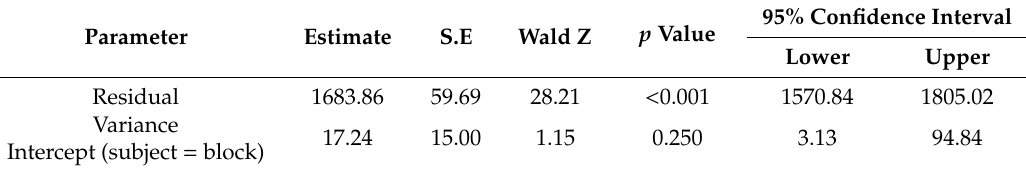
Table A5. Generalized linear mixed model (GLMM) estimates of the covariance parameters on the relative diameter growth at the base (%), grouped by plants within blocks as a random e ff ect with a first − order autoregressive structure and combining treatments into two classes, in the experimental plot after the irrigation